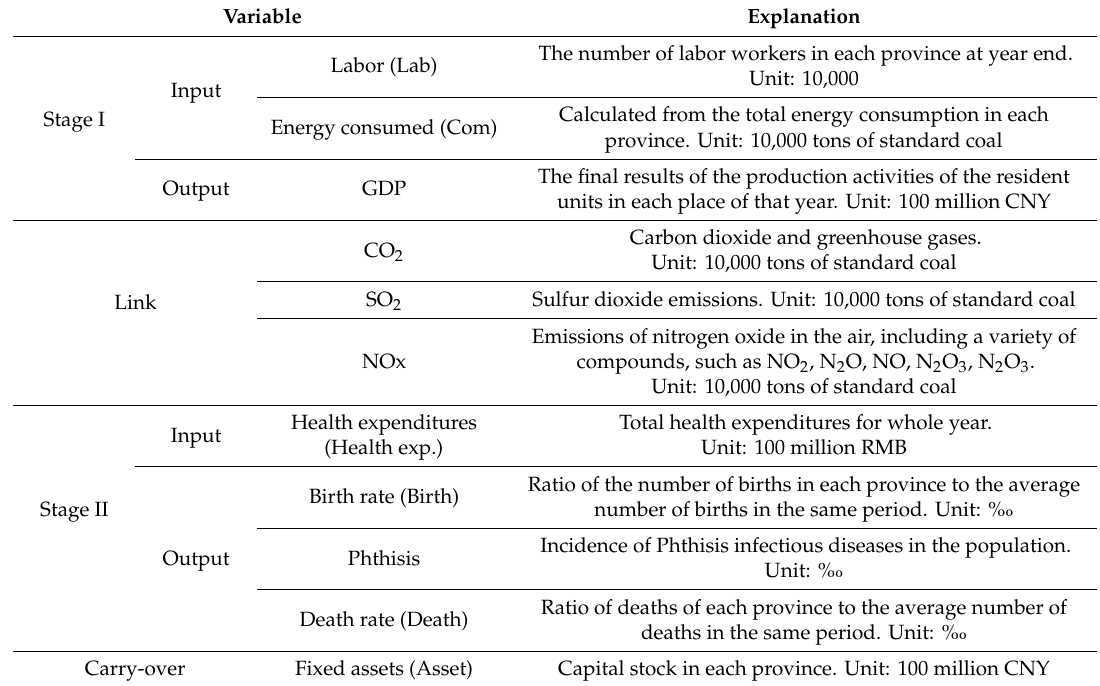
Table 1. Input and output variables of two